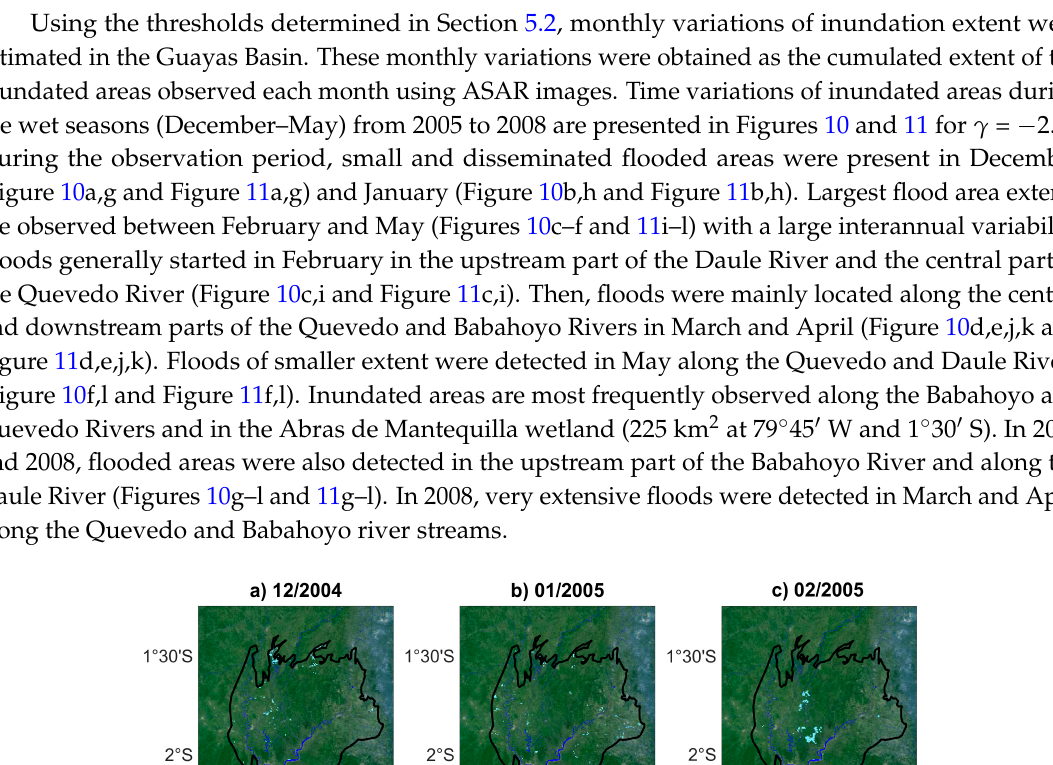
Figure 9. Maps of annual normalized anomalies of backscattering coefficients lower than a given threshold (light blue) in the Guayas floodplain (black line). The threshold values γ equals to − 2.25 in 2005 ( a ); 2006 ( d ); 2007 ( g ); and 2008 ( j ); − 2.30 in 2005 ( b ); 2006 ( e ); 2007 ( h ); and 2008 ( k ); − 2.35 in 2005 ( c ); 2006 ( f ); 2007 ( i ); and 2008 ( l ). Background image is from Google Maps. Permanent water bodies appear in blue.